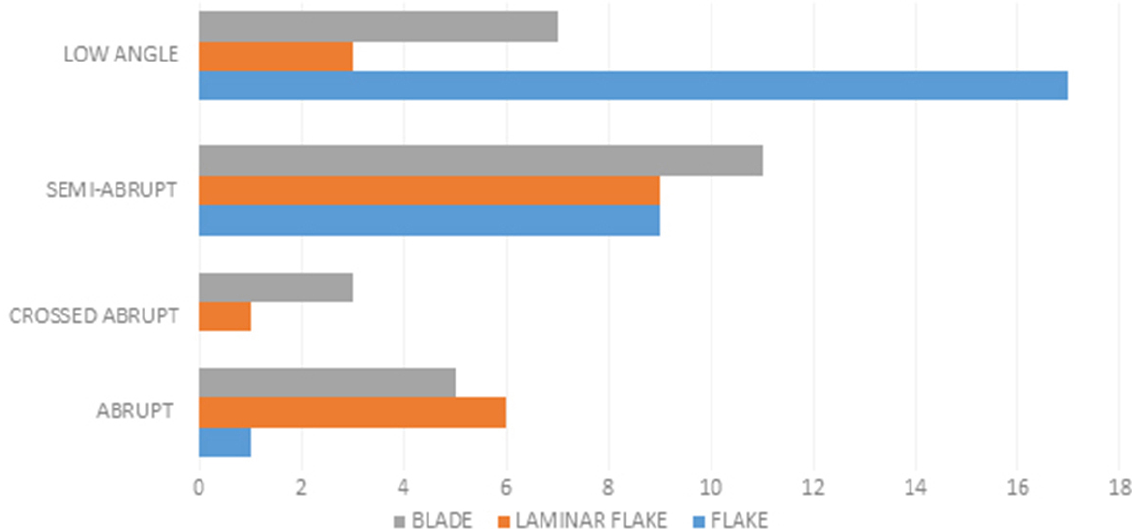
Figure 10. Representation of the angle of retouch from the total of retouched